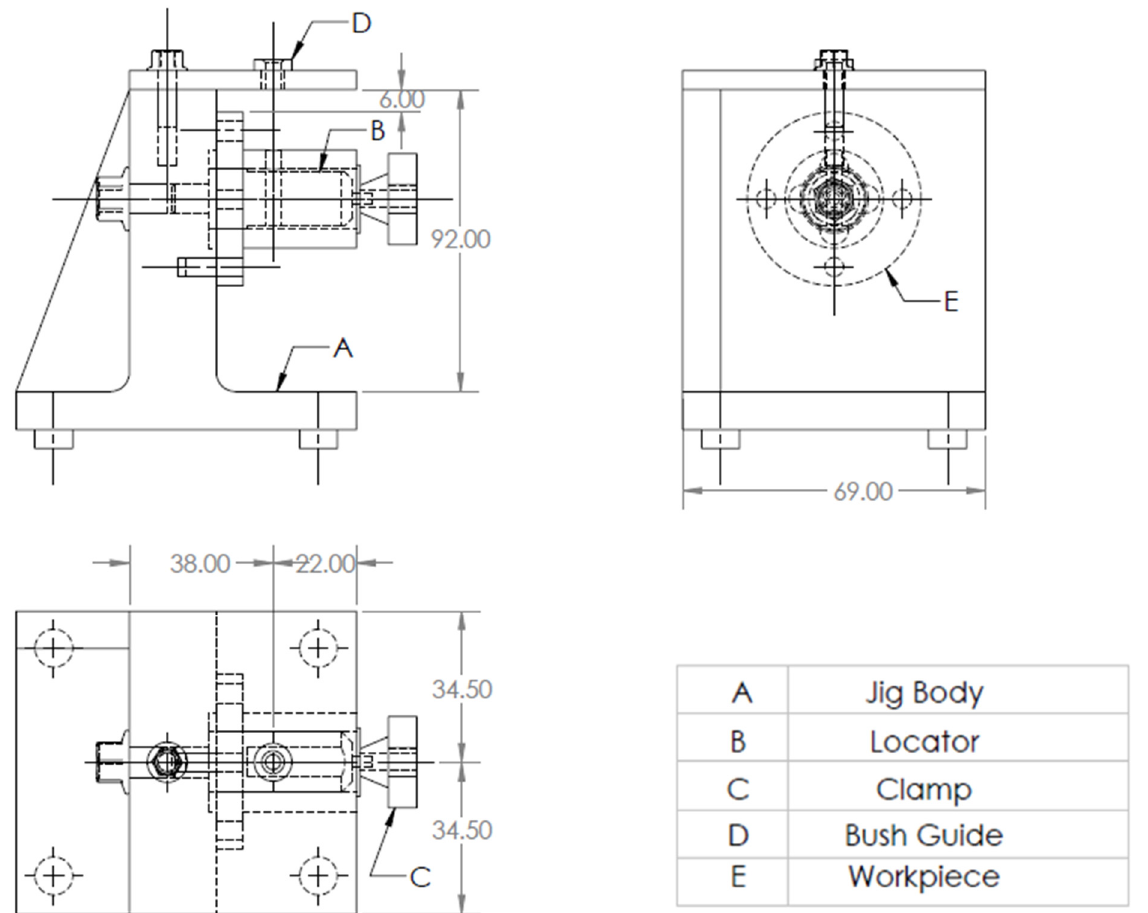
Figure 17. A drawing for the required jig design of the part.